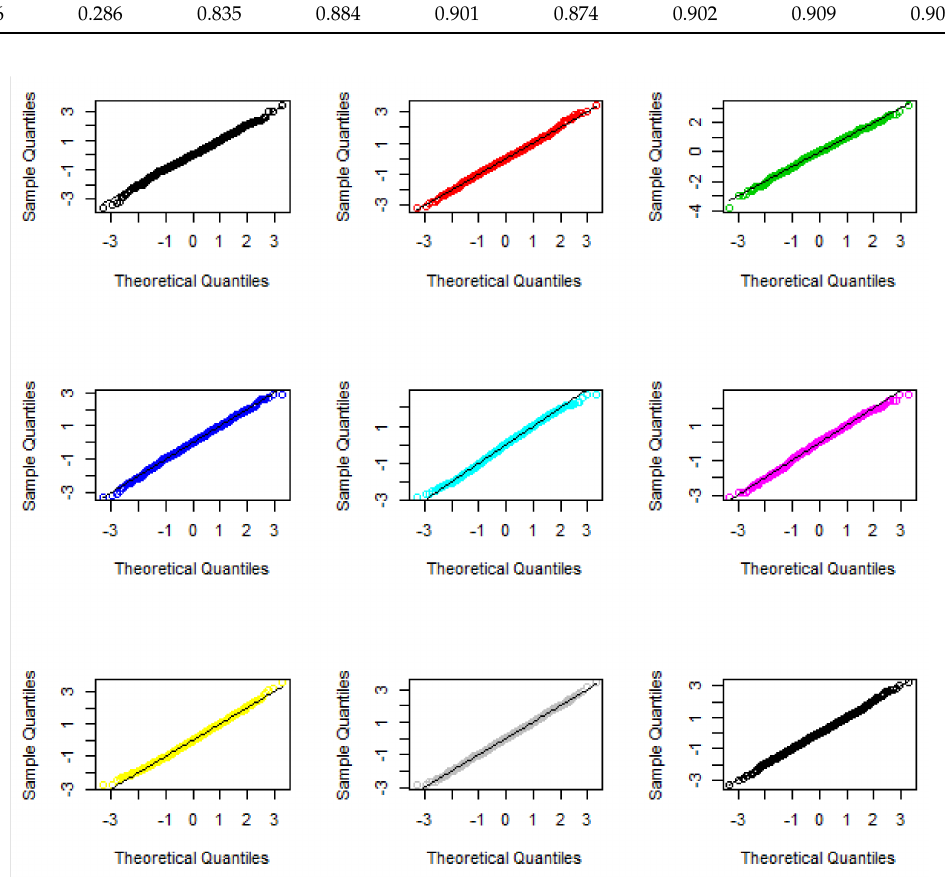
Figure 4. The Q–Q plots used to investigate the normality of the statistic T 0 . First column: Up: ( CV X , CV Y ) = ( 1, 1 ) and ( m , n ) = ( 50, 100 ) ; middle: ( CV X , CV Y ) = ( 1, 2 ) and ( m , n ) = ( 75, 100 )